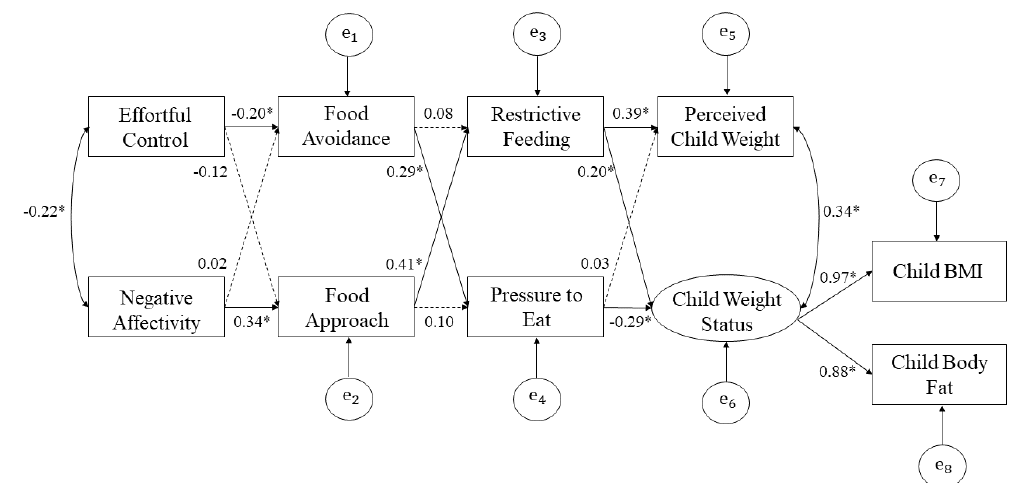
Figure 2. Final structural equation model with standardized path coe ffi cients. * p < 0.05. Dashed lines are non-significant paths. Note. BMI = body mass index; e 1 = error term for food avoidance; e = error term for food approach; e = error term for restrictive feeding; e = error term for pressure to eat; e = error term for 2 3 4 5 perceived child weight; e 6 = error term for child weight status; e 7 = error term for child BMI; e 8 = error term for child body